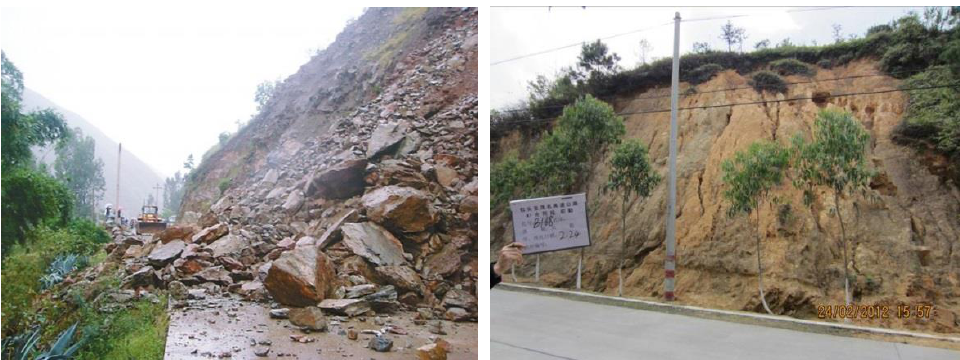
Figure 11. Collapse and falling in a red-bed rock slope in South China